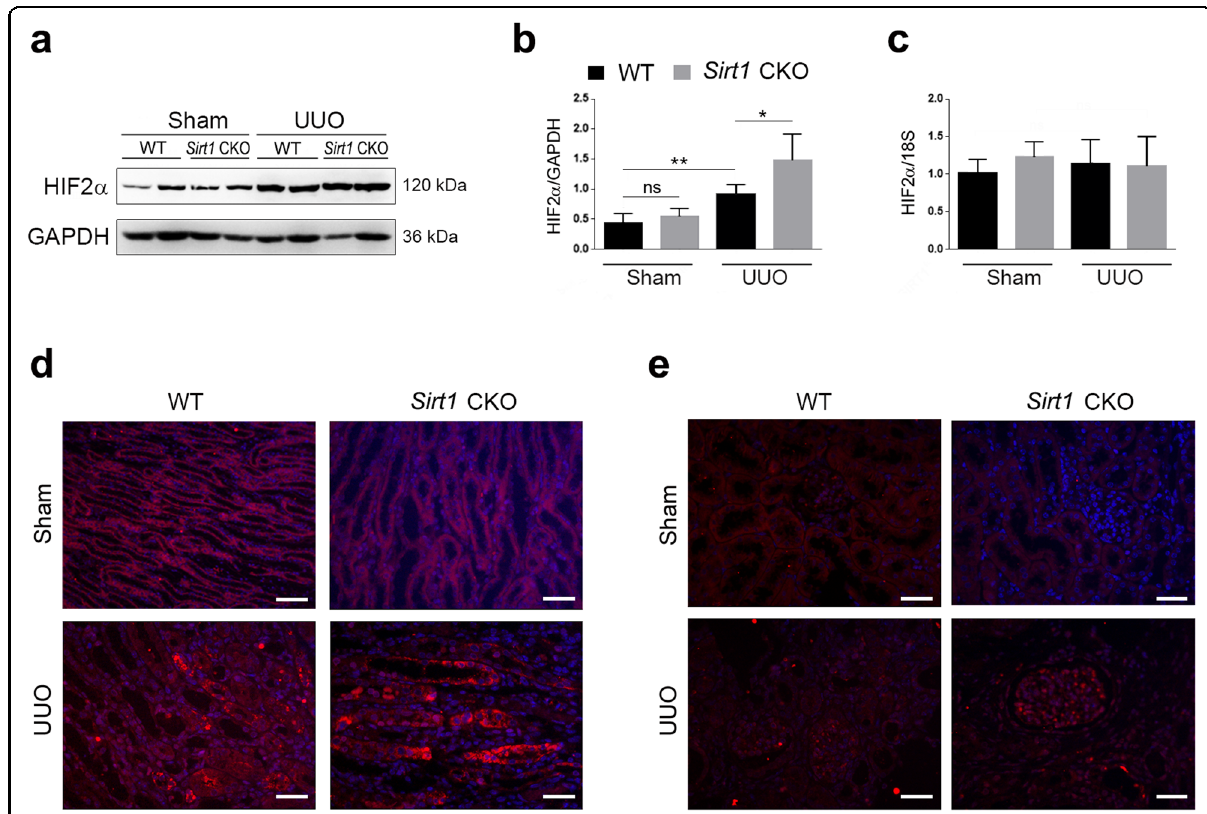
Fig. 4 HIF-2 α in the kidney is stimulated by UUO injury. a UUO injury increases HIF-2 α protein levels in kidneys of WT and Sirt1 CKO mice. Protein levels were analyzed by western blot analysis and GAPDH was used as a loading control. b Quantitative analysis of western blot data as shown in a . c HIF-2 α mRNA levels were not altered by UUO surgery. Gene expression was analyzed by qRT-PCR and 18S was used as a house-keeping gene. d – e HIF-2 α in the renal tubule ( d ) and glomerulus ( e ) were analyzed by immuno fl uorescence. Scale bar = 20 μ m. n = 6. Data are means ± SEM. ns: no signi fi cance. * P > 0.05, ** P <